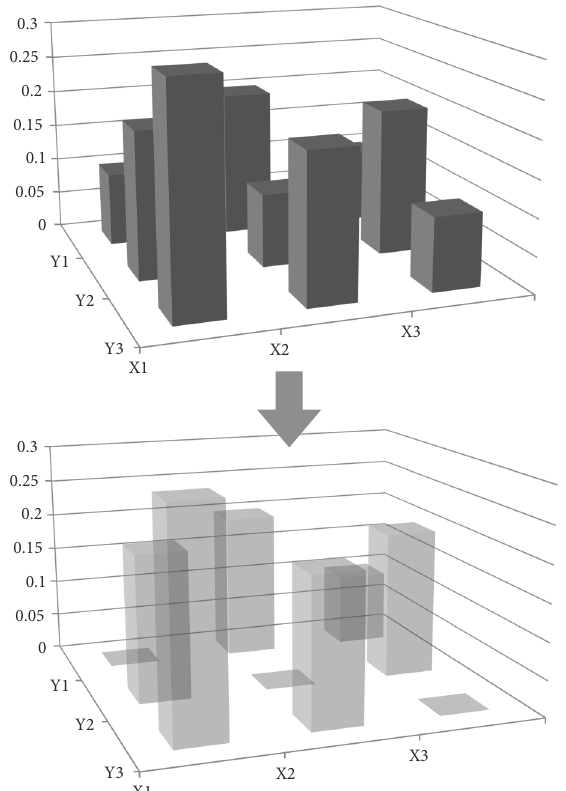
Figure 2. Trust fusion effects (the initial agglomeration is shown at the top, and trust fused agglomeration at the